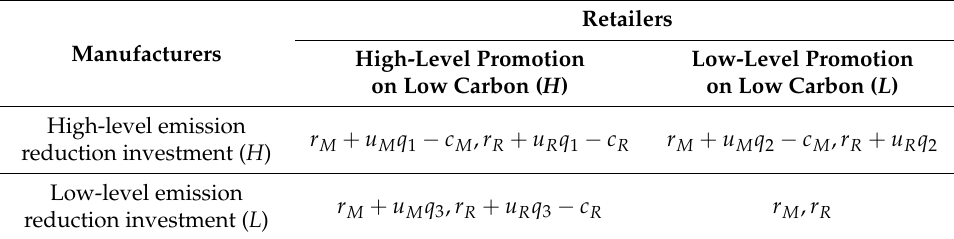
Table 1. A pay-off matrix of two